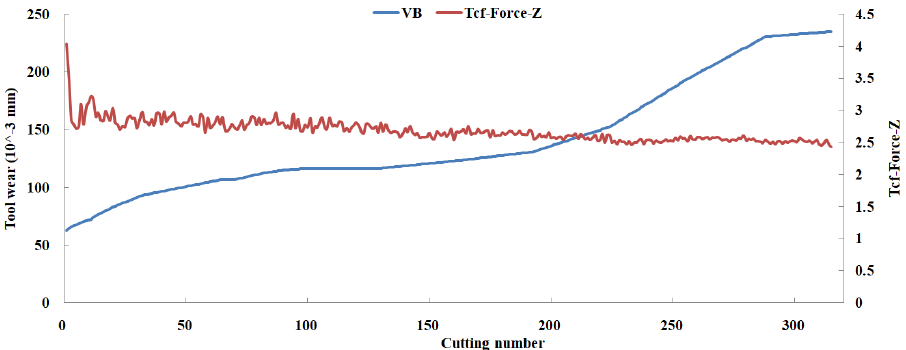
Figure 17. The scatter diagram between T sd in Z-dimension Force and tool wear value.